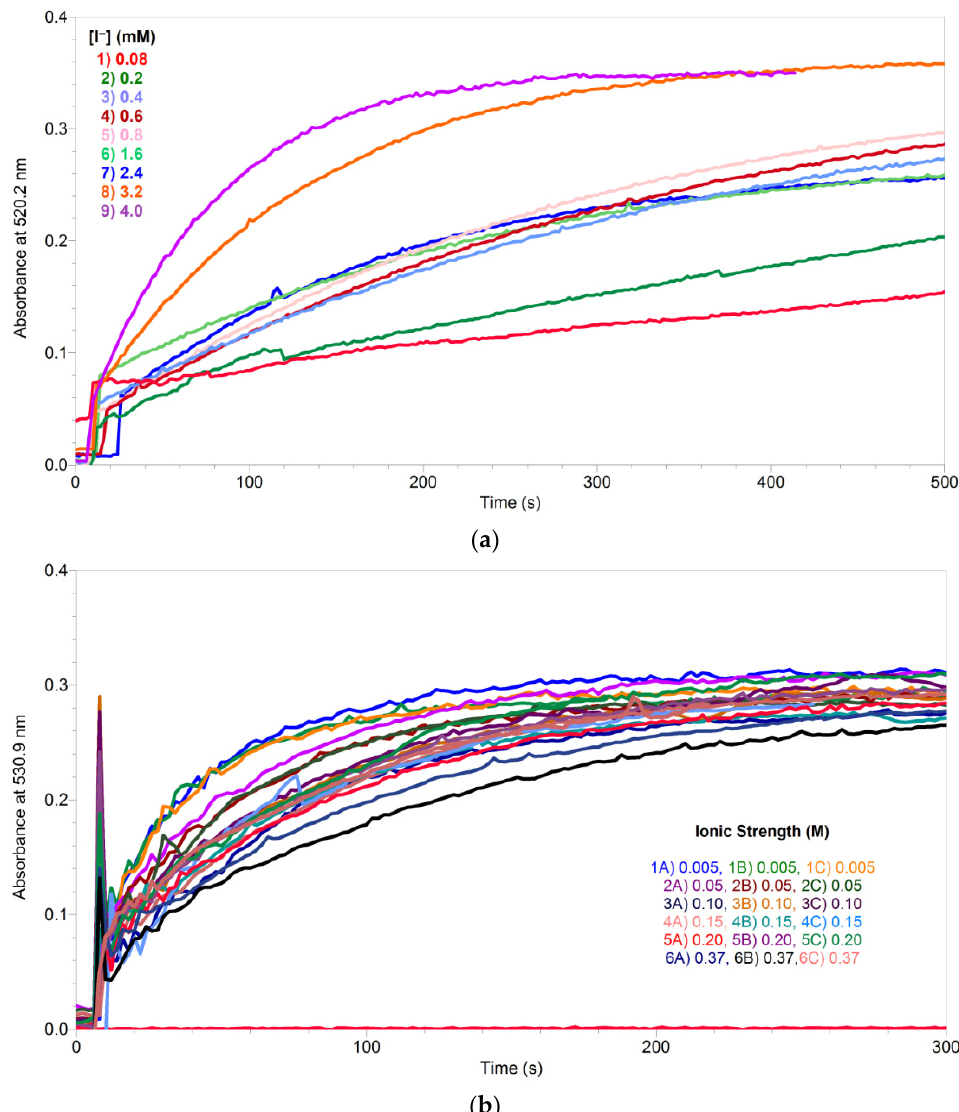
Figure 1. Linear rate equation of integration method for zero-order reaction at 3.2 mM iodide.